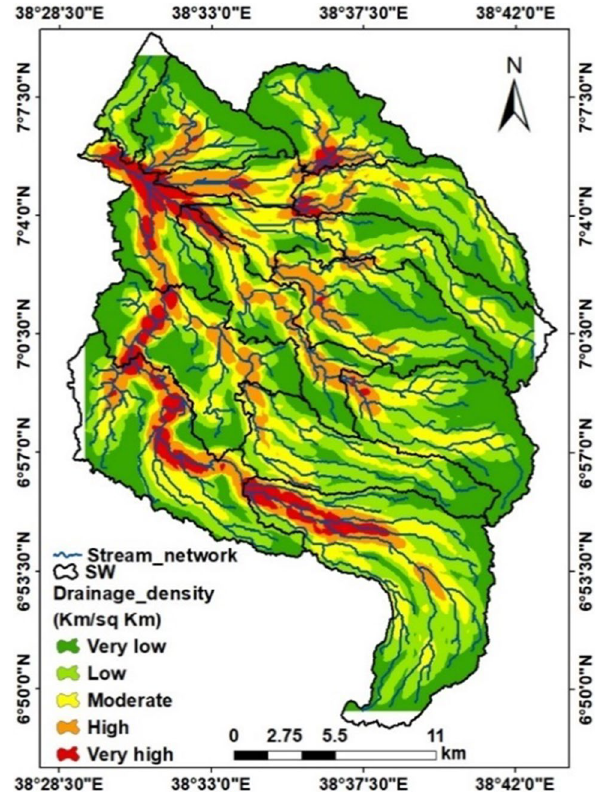
Fig. 6 Drainage density distribution